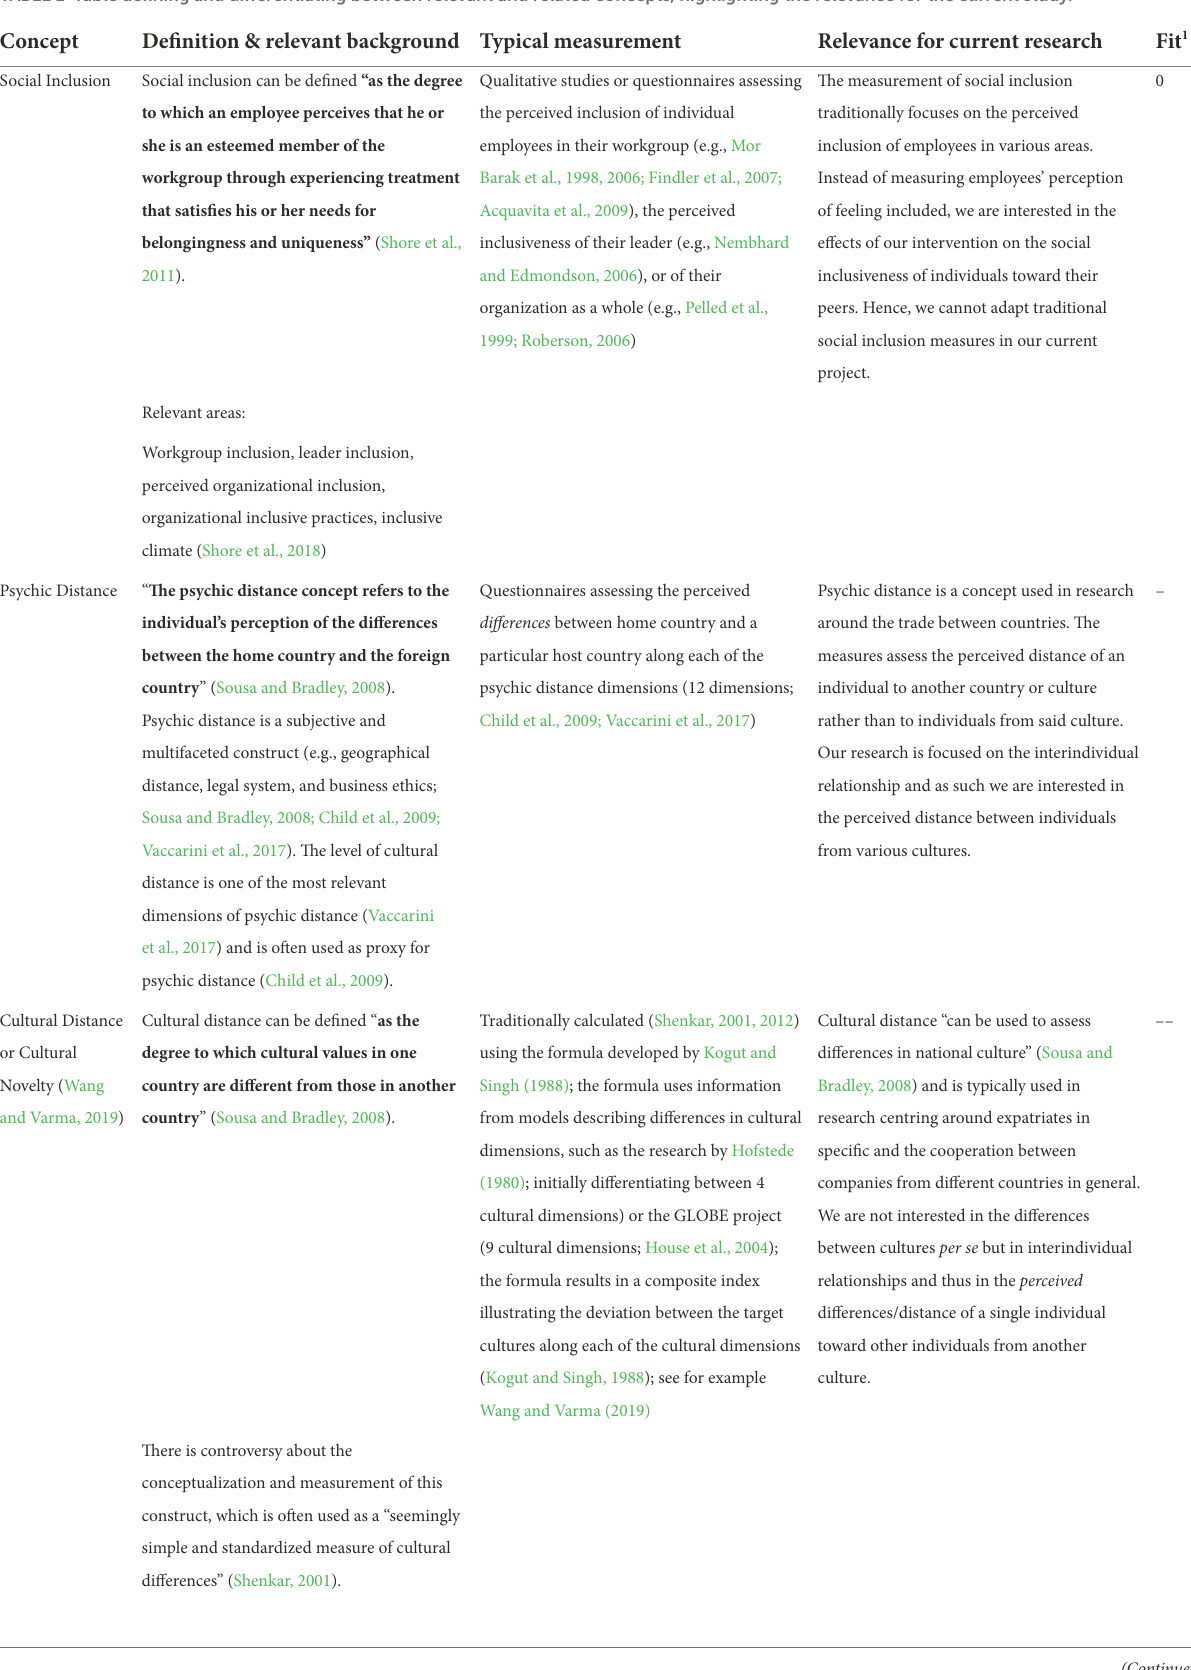
TABLE 1 Table defining and differentiating between relevant and related concepts, highlighting the relevance for the current study.